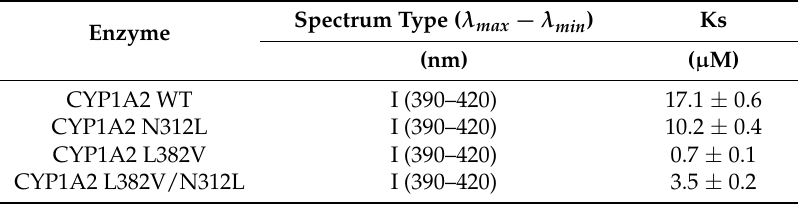
Table 1. Spectral binding constants for phenacetin with purified CYP1A2 WT and the mutants at 27 ◦ C. The two cuvettes contained 0.5 µ M CYP1A2 WT or the mutant in 0.1 M phosphate buffer, pH 7.4, with 20% glycerol. Difference spectra were obtained after the addition of increasing concentrations of substrate to the sample cuvette.